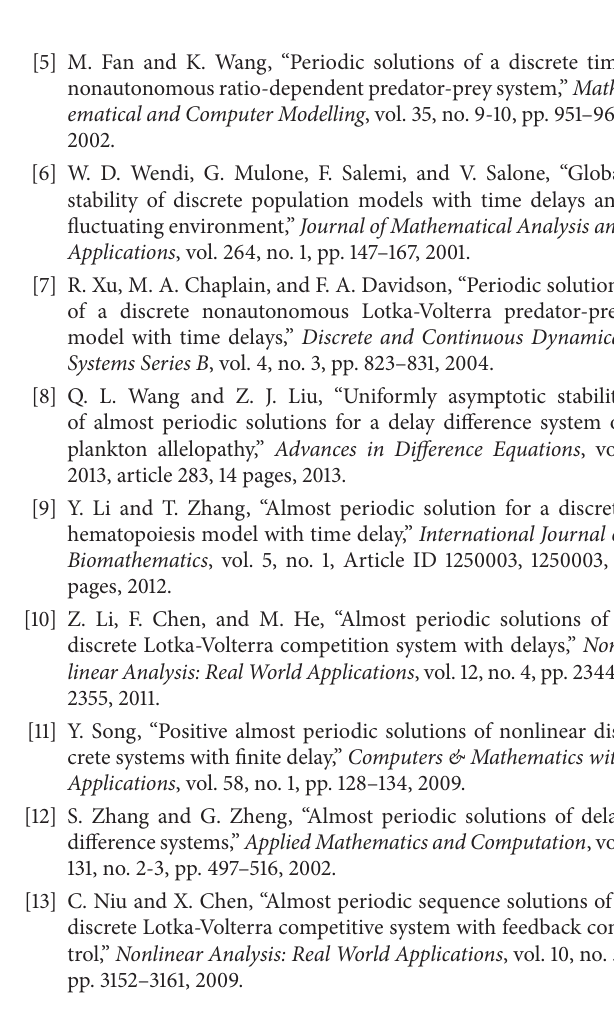
Figure 6: Uniformly asymptotic stability. (a) Time-series of 𝑥 + 1 (𝑛) and 𝑥 1 (𝑛) with initial values 𝑥 + 1 (−1) = 0.79 and 𝑥 + 1 (0) = 0.80 and 𝑥 1 (−1) = (0) = 0.92 for 𝑛 ∈ [0, 100] , respectively. (b) Time-series of 𝑥 + 0.83 and 𝑥 1 (0) = 0.79 and 𝑥 (−2) = 0.81 , 𝑥 (−1) = 0.79 , and 𝑥 𝑥 + 2 2 2